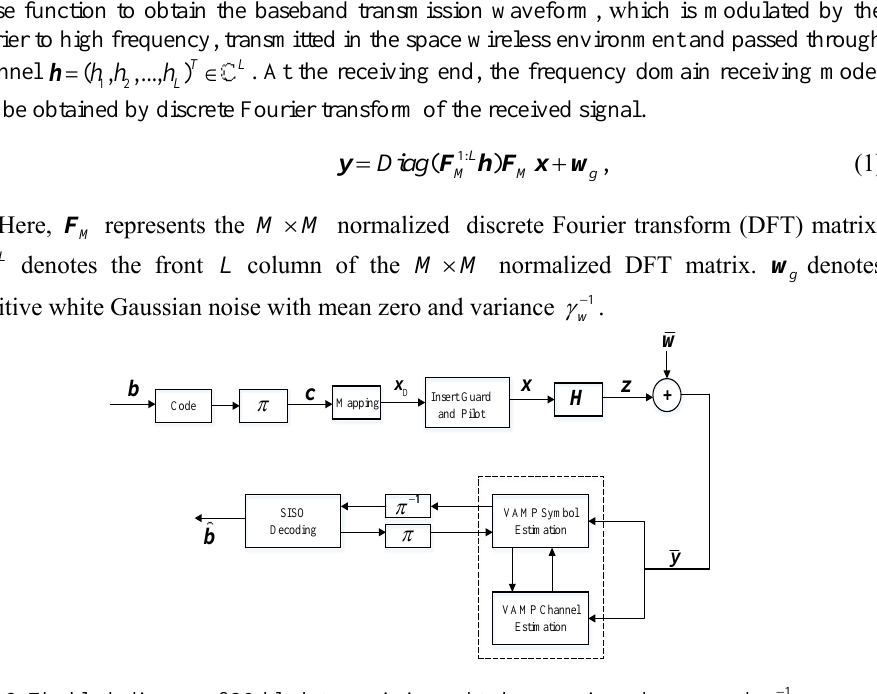
Fig. 2. The block diagram of SC block transmission and turbo reception, where  and 1   represent interleaving and deinterleaving, respectively, and H represents channel propagation. Virtual frame shows reception using a SISO equalizer that iterates between symbol and channel estimation, which uses VAMP for joint symbol and channel